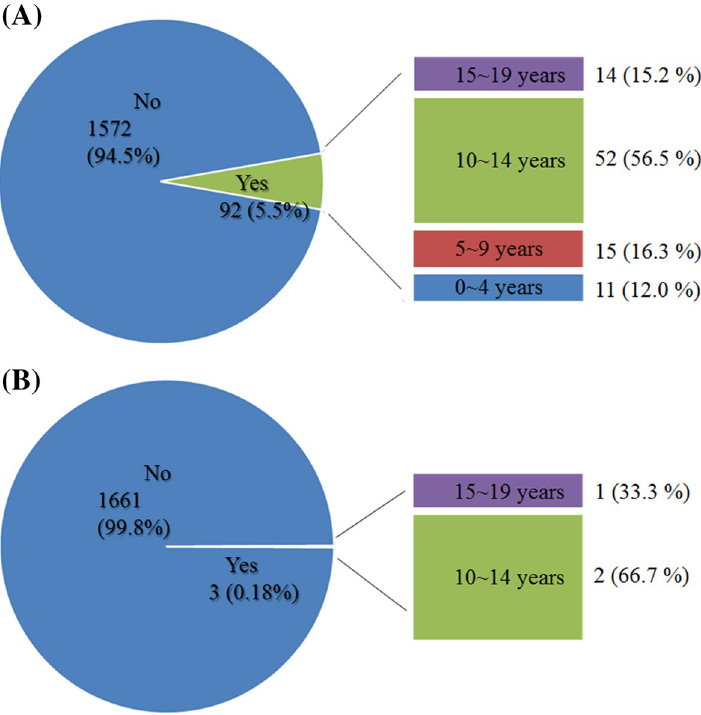
Figure 5. Diagrams showing the proportion of patients with CS who underwent surgical treatment: ( A ) Posterior surgical treatment, and ( B ) Anterior surgical treatment. Data were extracted through the following procedure codes (N0444, N0445 for anterior surgery; N0446, N0447 for posterior surgery), from 2011 to 2015. Patients corresponding to ‘Yes’ are separately stratified according to age, and the patterns of patients